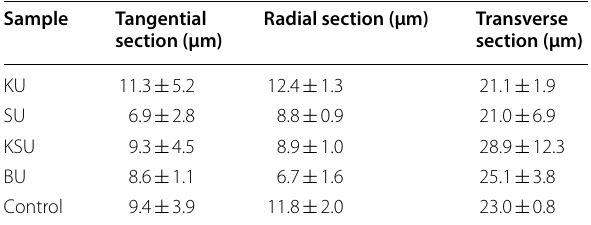
Table 3 Roughness value (RMS) of the sample surfaces (mean ±